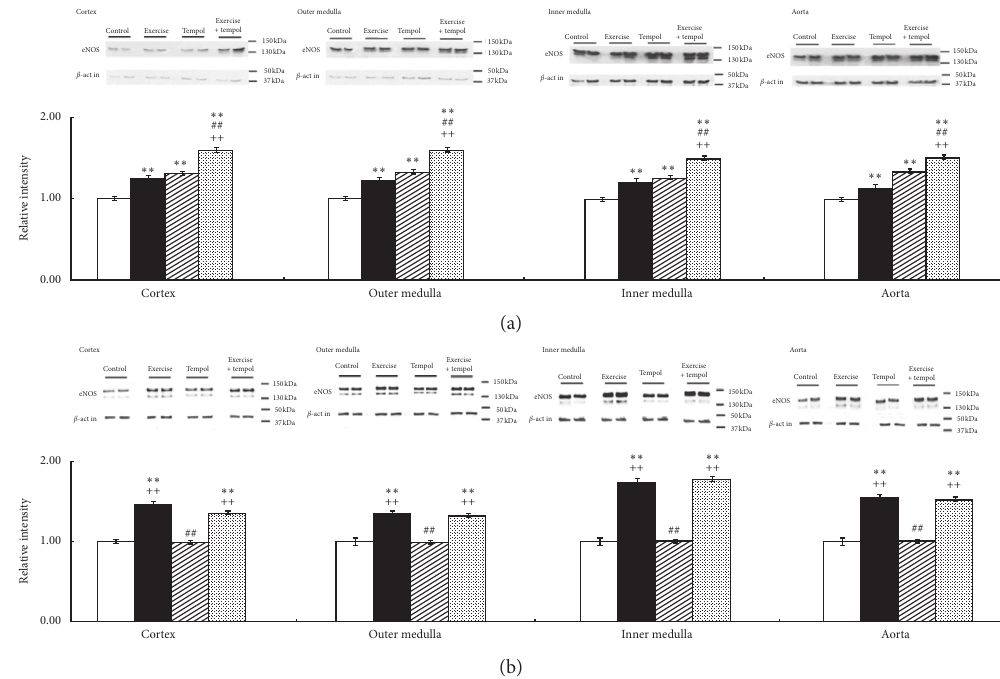
Figure 7: Effects of Ex and tempol on the levels of nNOS in SHR and WKY. The protein levels of nNOS in the renal cortex, outer medulla, inner medulla, and aorta of SHR (a) and WKY (b) were compared among the control group (open bars), Ex group (closed bars), Tmp group (hatched bars), and Ex +Tmp group (checked bars) ( n � 10 in each group). Top panel shows representative immunoblots of nNOS, middle panel shows the immunoblots of β -actins, and bottom panel shows data of the densitometric analysis. ∗ P < 0 . 05 vs. the control group. ∗∗ P < 0 . 01 vs. the control group. ## P < 0 . 01 vs. the Ex group. ++ P < 0 . 01 vs. the Tmp